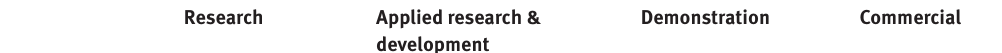
Table 2: The use of silver nanoparticles - a commercialization level [3].